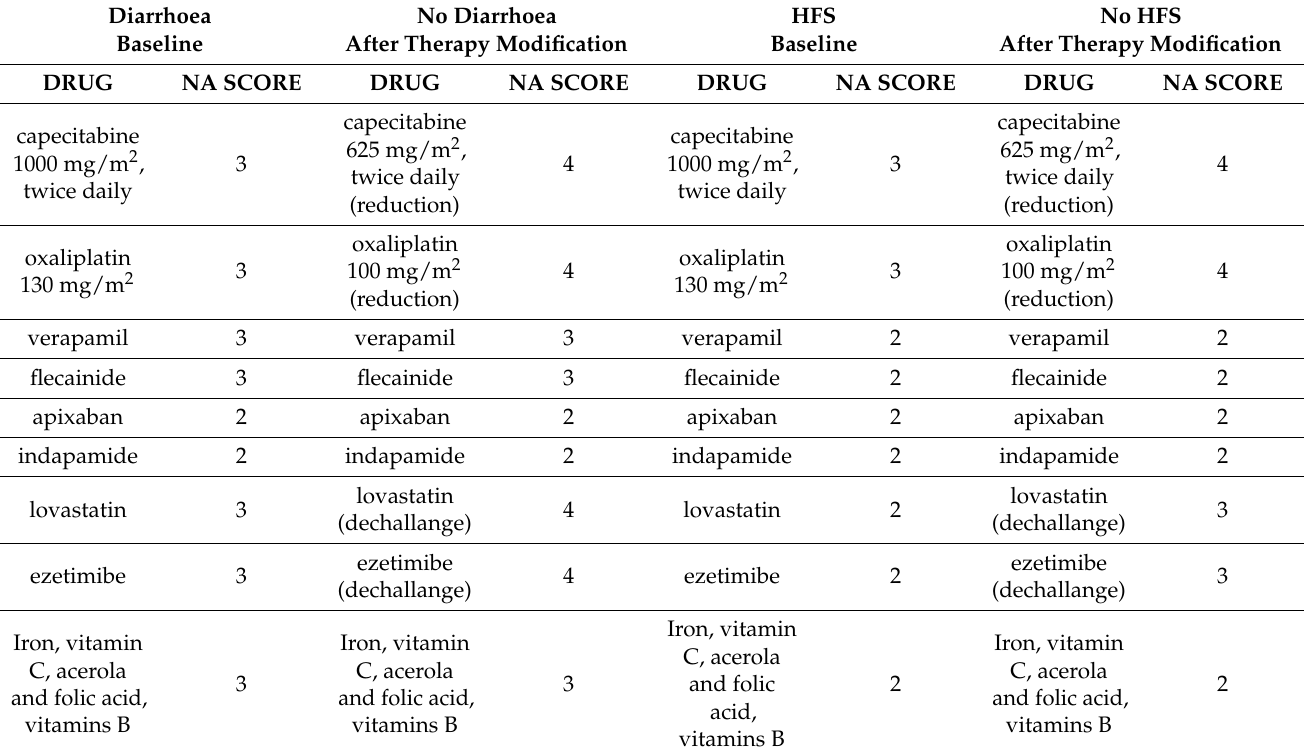
Table 3. Causality assessment performed using Naranjo Algorithm for patient